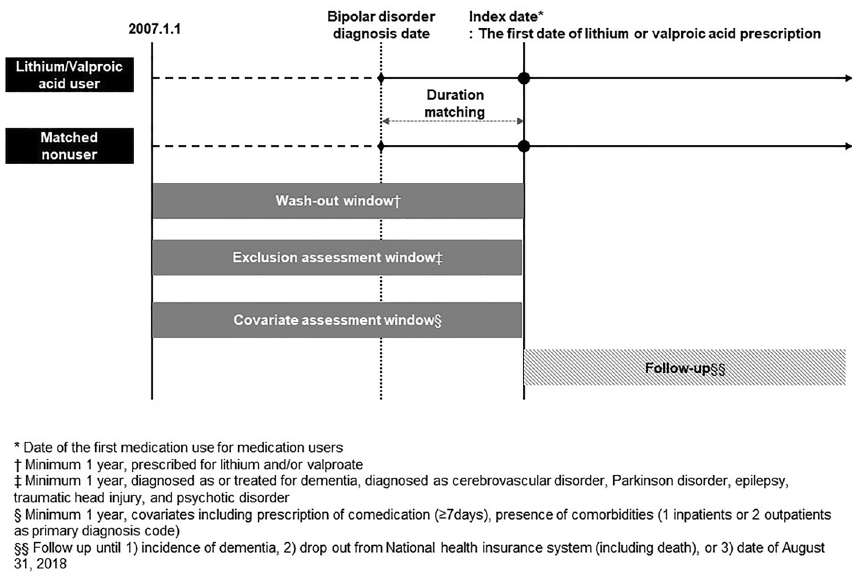
Figure 2. Description of study